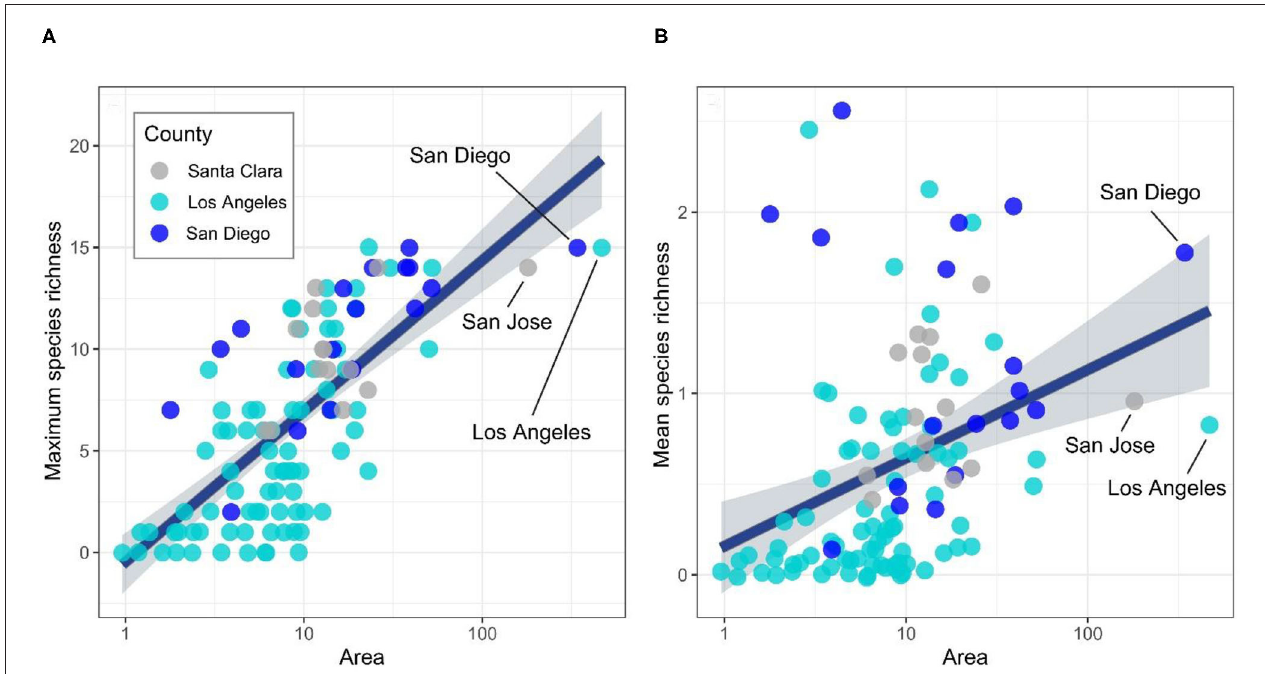
FIGURE 1 | Scatterplot and least-squares fitted line with confidence intervals (gray shaded area) depicting the relationship between city size (Area) and (A) maximum and (B) mean indicator species richness. Each dot represents a city, and colors denote the county of city origin. The three largest cities of this analysis are marked for visualization purposes. In (B) , we noted that while all three largest cities fall significantly in their ranking in mean species, San Diego lies above the fit line, whereas Los Angeles and San Jose fall below.